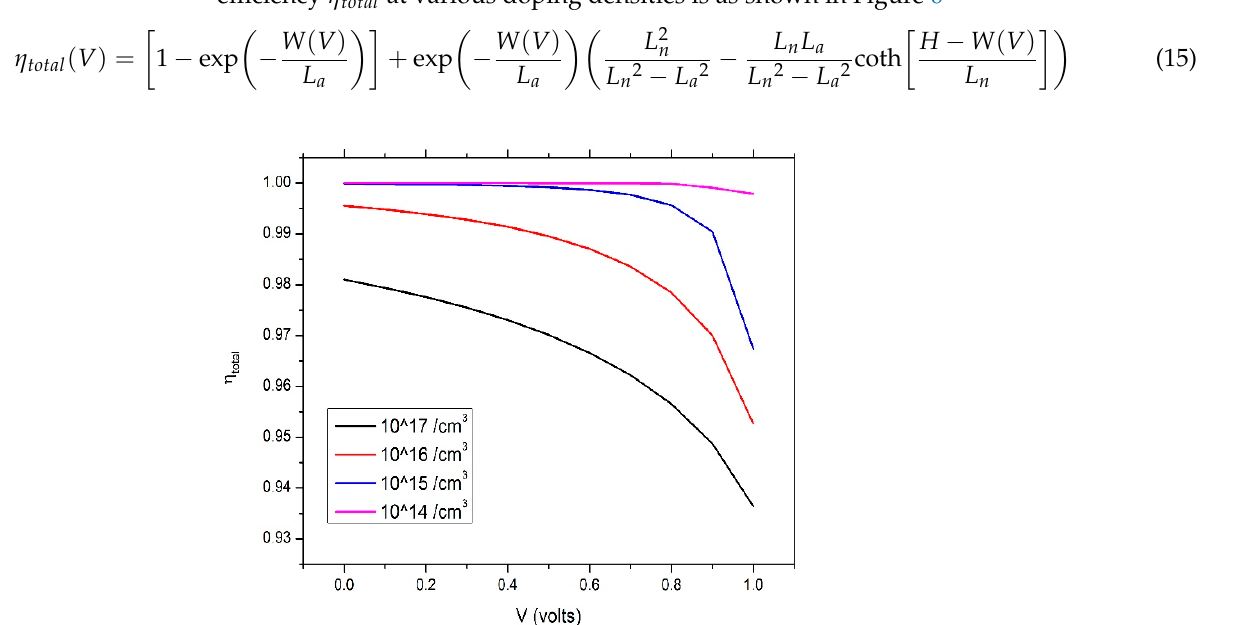
Figure 6. The ideal polycrystalline thin-film CdTe solar cell’s photo-carrier collection efficiency at various doping densities.